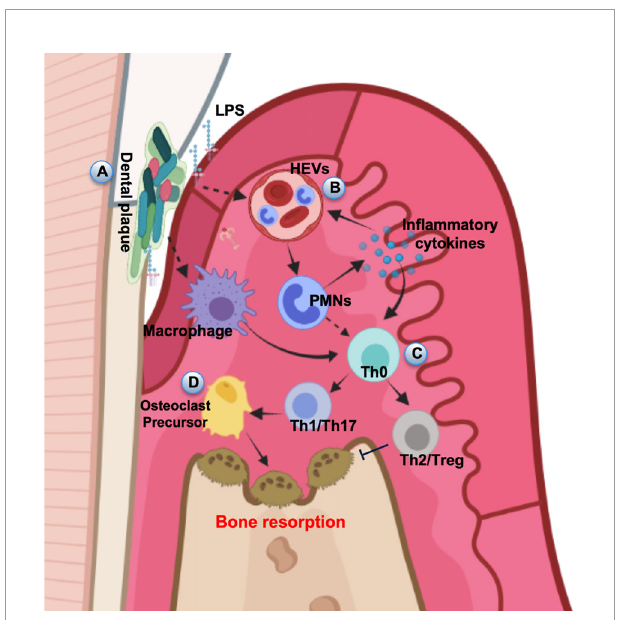
FIGURE 1 | Pathogenesis of periodontal disease. (A) In periodontal tissue, the dental plaque stimulates local in fl ammatory and immune responses. (B) LPS and other plaque PAMPs as well as DAMPs activate the HEVs leading to vascular hyperpermeability and leakage PMN transmigration. (C) APCs interact with naive T helper cells, driving their differentiation into several subsets. (D) The ampli fi cation of local immune response leads to the development of in fl ammation and results in the progression of periodontal destruction and bone